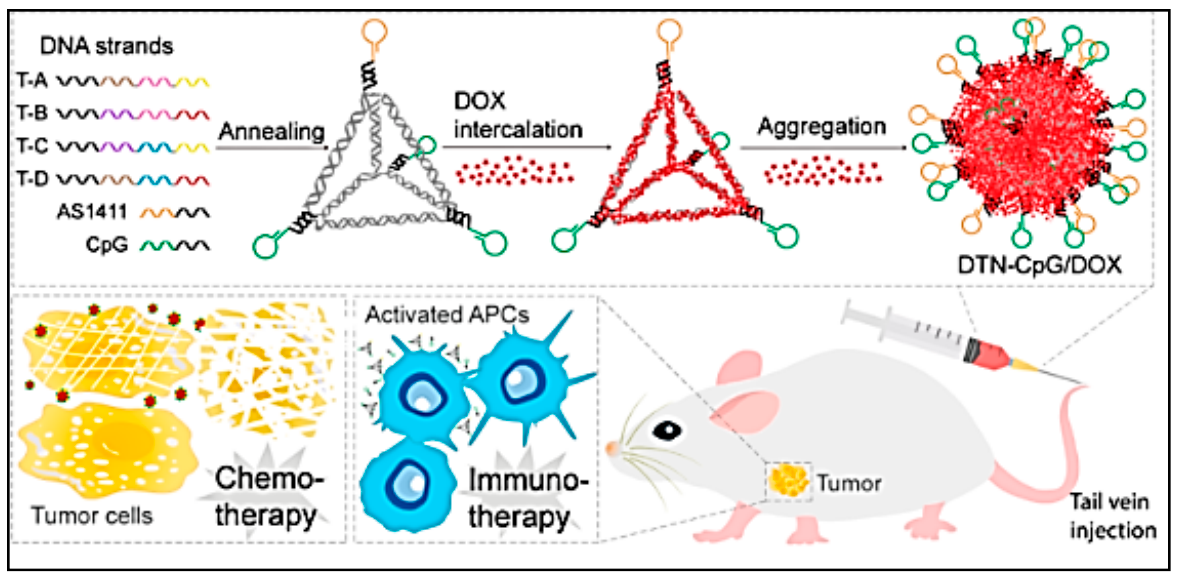
Figure 6. Development of a DNA nanocarrier co-encapsulating CpG and doxorubicin for chemoim- munotherapy. The nanoparticle administration offered superior therapeutic outcome due to the synergistic action of the activated antigen presenting cells and cytotoxicity of the chemotherapeutic agent [96]. Reproduced with permissions from Qian Wang et al., ACS Applied Nanomaterials , Amer- ican Chemical Society, 2022.